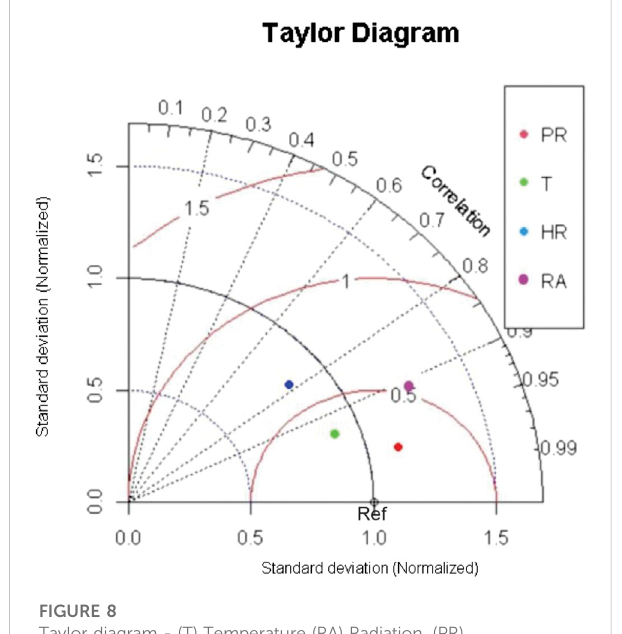
Taylor diagram - (T) Temperature (RA) Radiation, (PR) Precipitation, (HR) Relative Humidity.